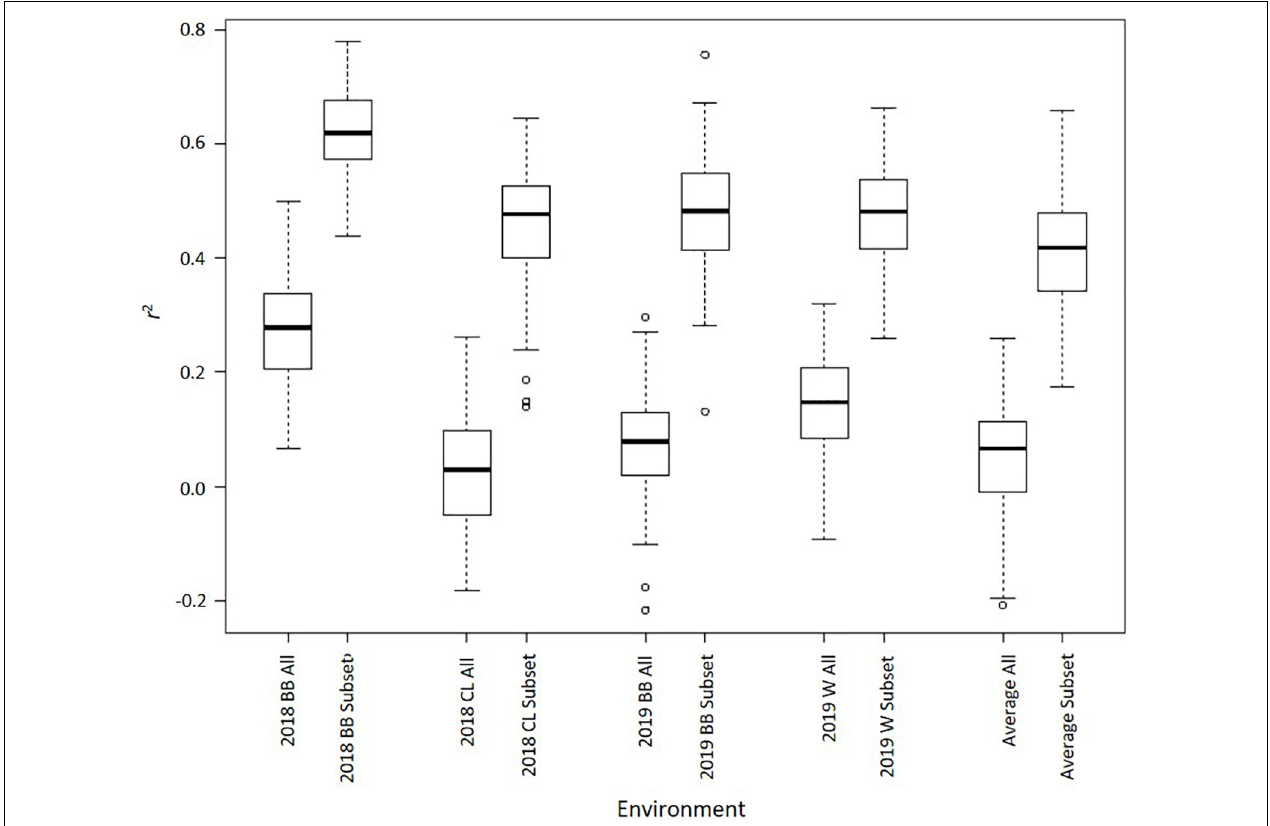
FIGURE 5 | Boxplots displaying 100 r 2 values ( k = 5, 20 iterations) for GS models using 35,570 SNPs (ALL) and 248 SNPs (Subset) across environments (BB = Blacksburg, VA; CL = Clayton, NC; W = Warsaw, VA; Average = Mean met across all